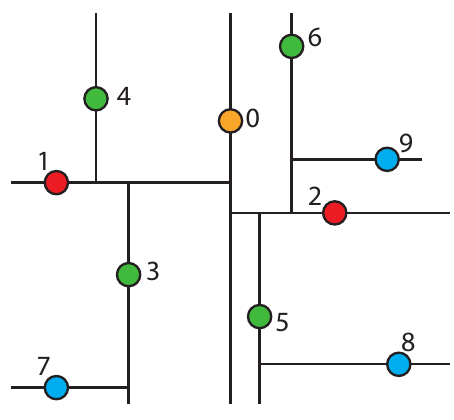
Figure 6. Fully constructed k-d tree.